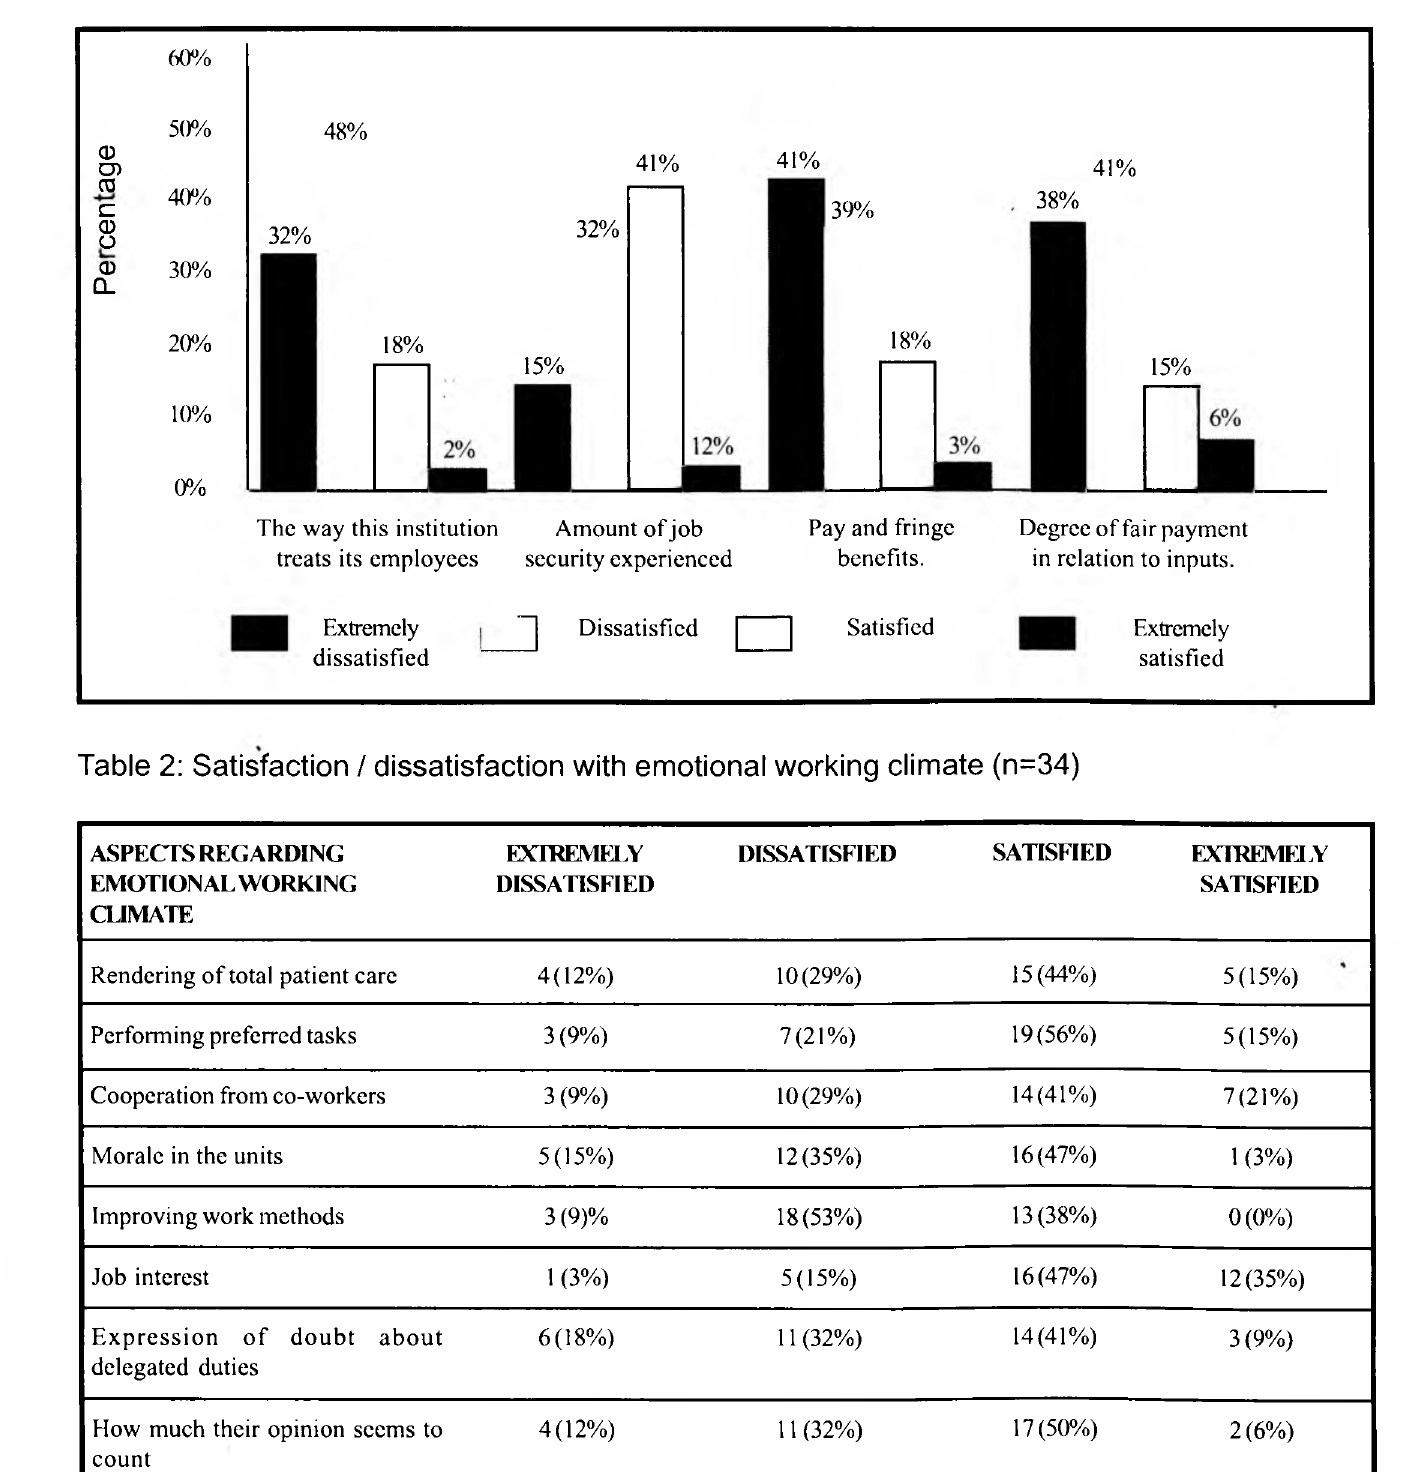
Figure 4: Factors relating to the post held (n=34)